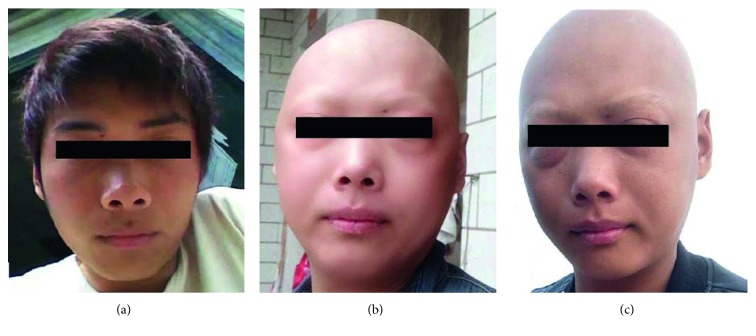
Case 1, 25-year-old male. (a) Before DIHS/DRESS; (b) July 2016, 4 months after DIHS/DRESS, the patient had no hair in the whole body; (c) September 2016, 6 months after DIHS/DRESS, eyebrow began to grow.